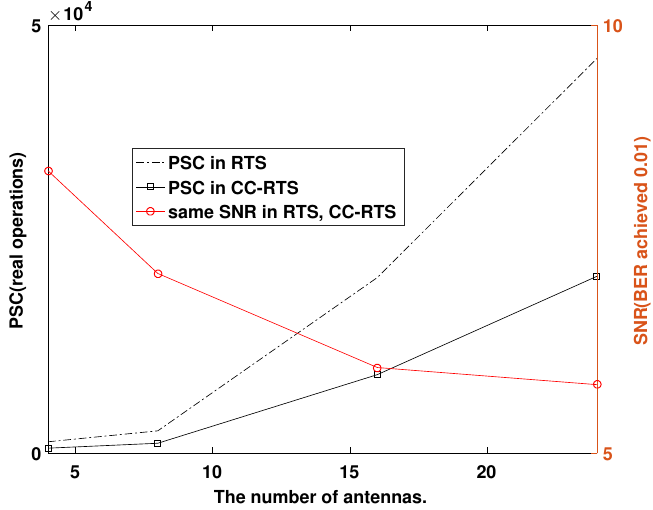
Figure 6. Per-symbol-complexity (PSC) in number of real operations and SNR required to achieve 10 − 2 BER in QPSK for 4 × 4, 8 × 8, 16 × 16, 24 × 24 MIMO system (Ref: Figure 5 ). Table 4. Per-symbol-complexity (PSC) in number of real operations and SNR required to achieve BER = 10 − 2 with QPSK for 4 × 4, 8 × 8, 16 × 16, 24 × 24 MIMO systems (Ref: Figure 5 ). Per-Symbol-Complexity in Number of Real Algorithm